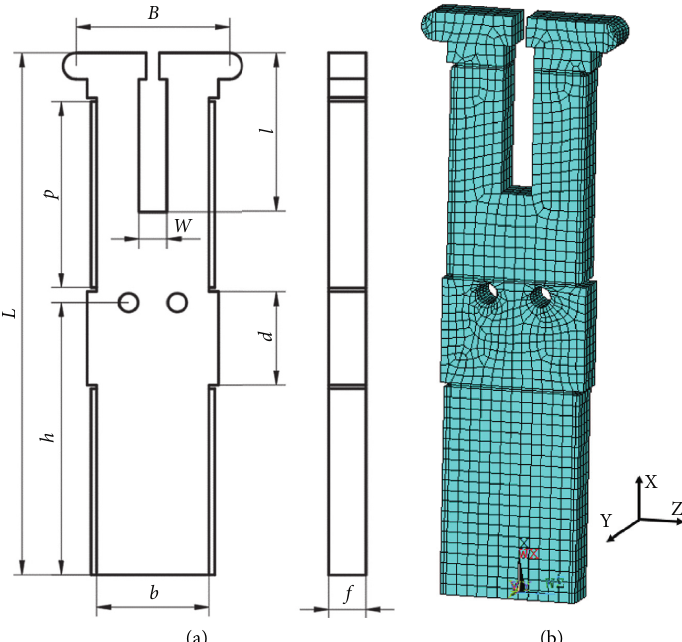
Figure 5: Main structure parameters and FE model of the stator. (a) Main structure parameters. (b) FE